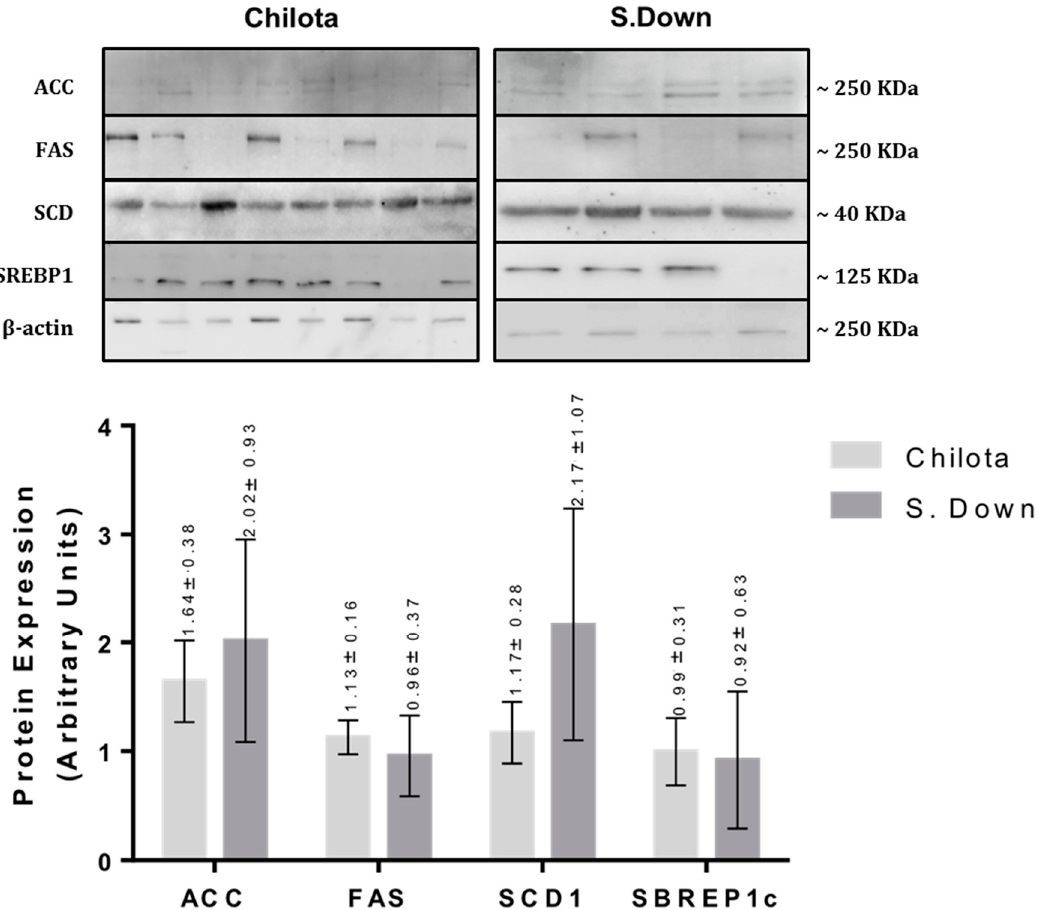
Figure 2. Protein expression levels of ACC, FAS, SCD1 and SREBP1c in tail fat from Chilota ( n = 8) and Suffolk Down ( n = 4) lambs grazing Calafatal pasture; analyzed by western blot. The LSM ± SEM values are shown above each bar of the graph. Normalized to β actin expression; p < 0.05.